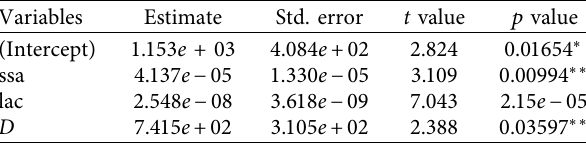
Table 4: Optimal result analysis.